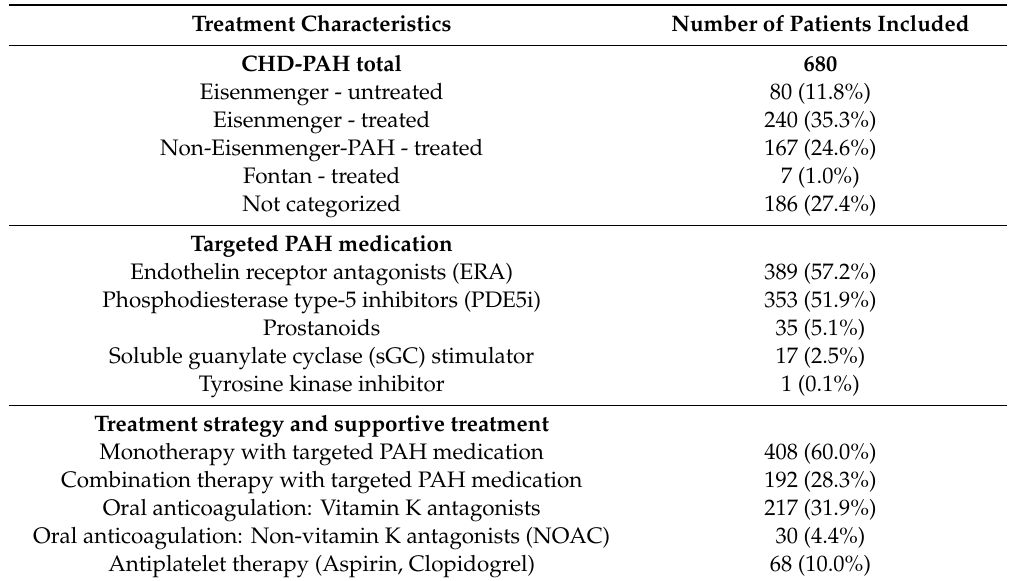
Table 2. Treatment characteristics of the patients with congenital heart disease-associated pulmonary arterial hypertension. “Non-Eisenmenger-PAH treated” comprises patients with congenital heart disease-associated pulmonary arterial hypertension but without Eisenmenger syndrome who received targeted PAH treatment. Abbreviations: PAH, pulmonary arterial